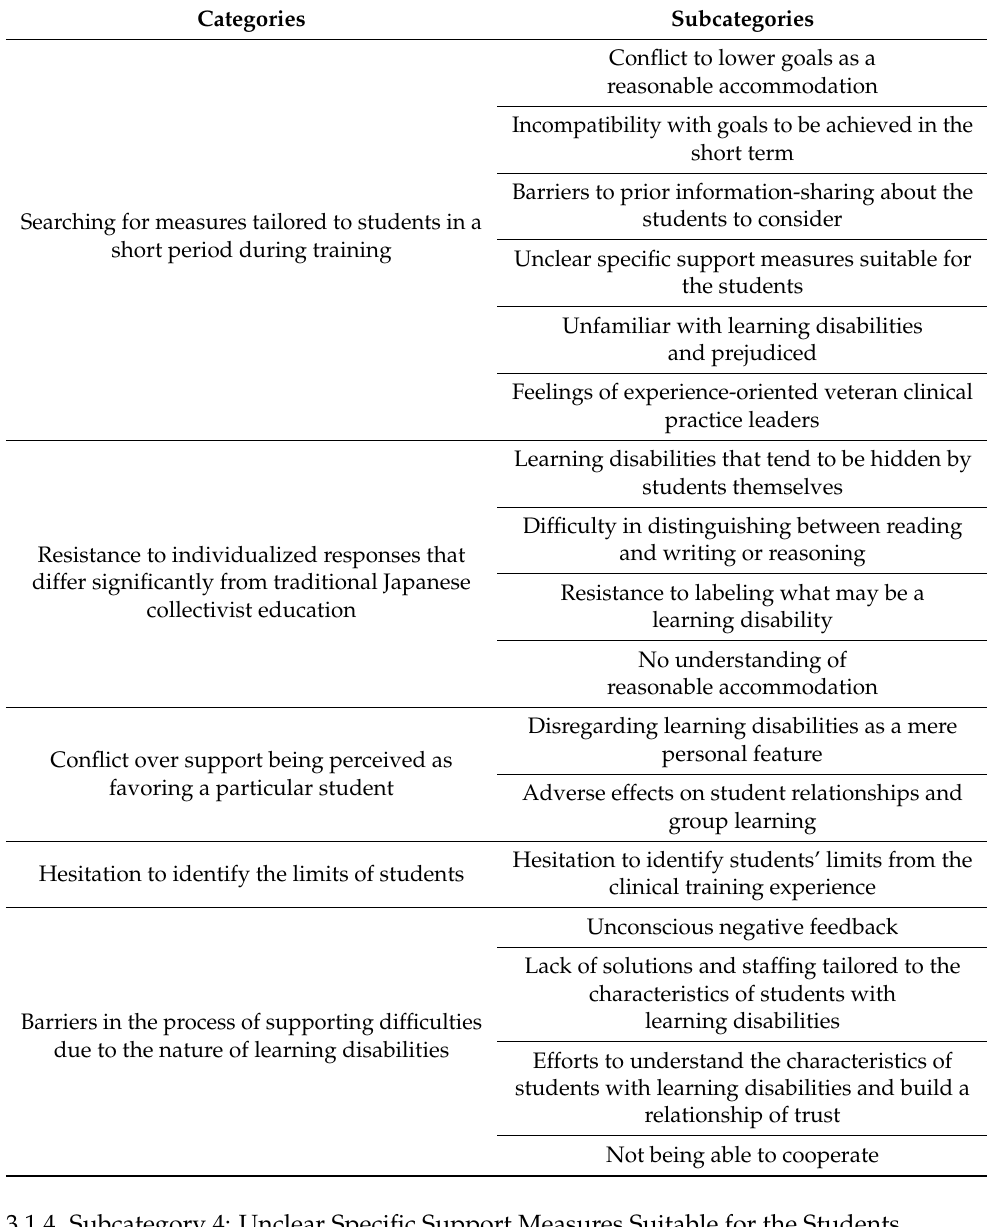
Table 2. Categories and subcategories of the difficulties faced by clinical instructors and university education staff working with nursing students with potential learning